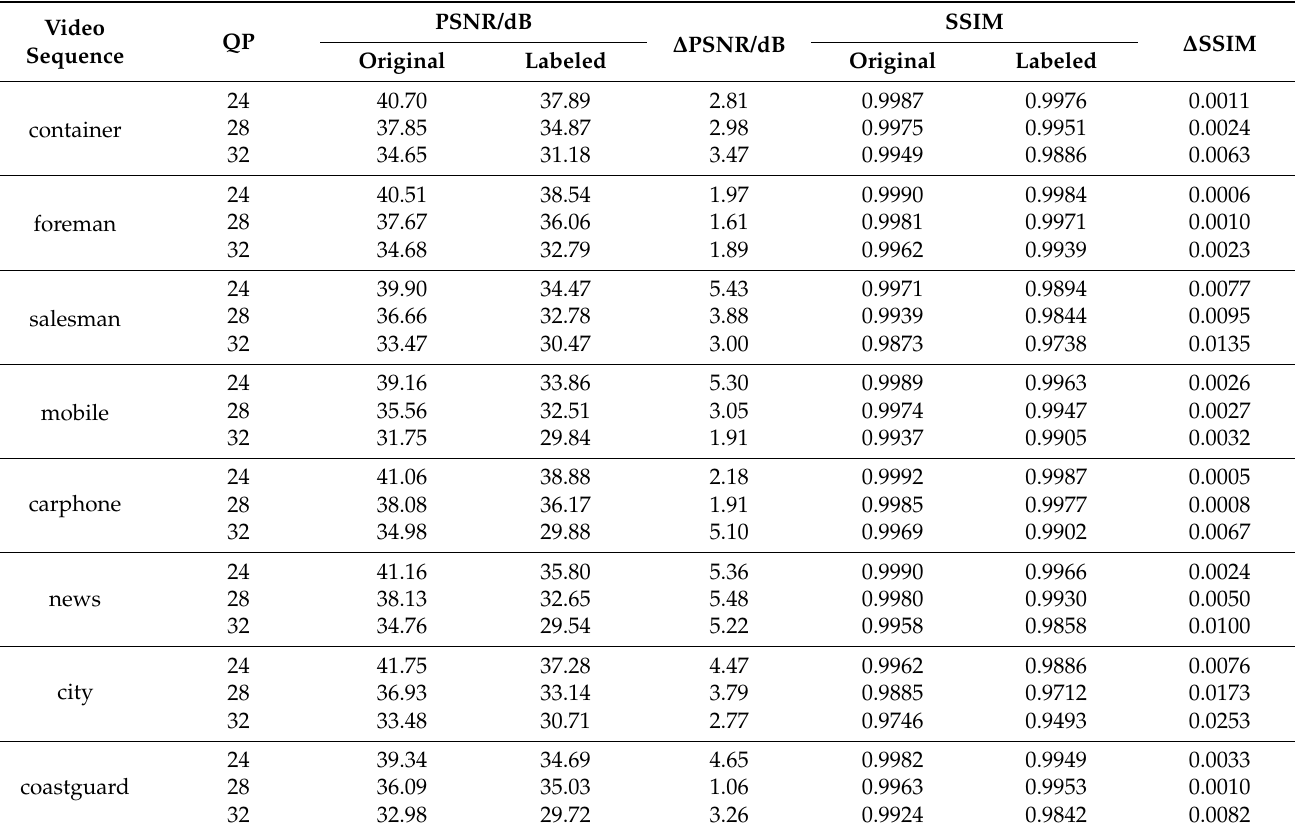
Figure 11. The corresponding decrypted labeled frames. Table 3. PSNR and SSIM of decrypted labeled